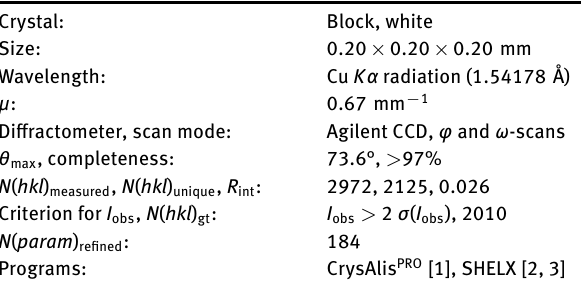
Table 1: Data collection and